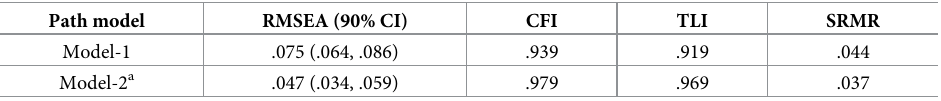
Table 1. Summary for DB-M model fit